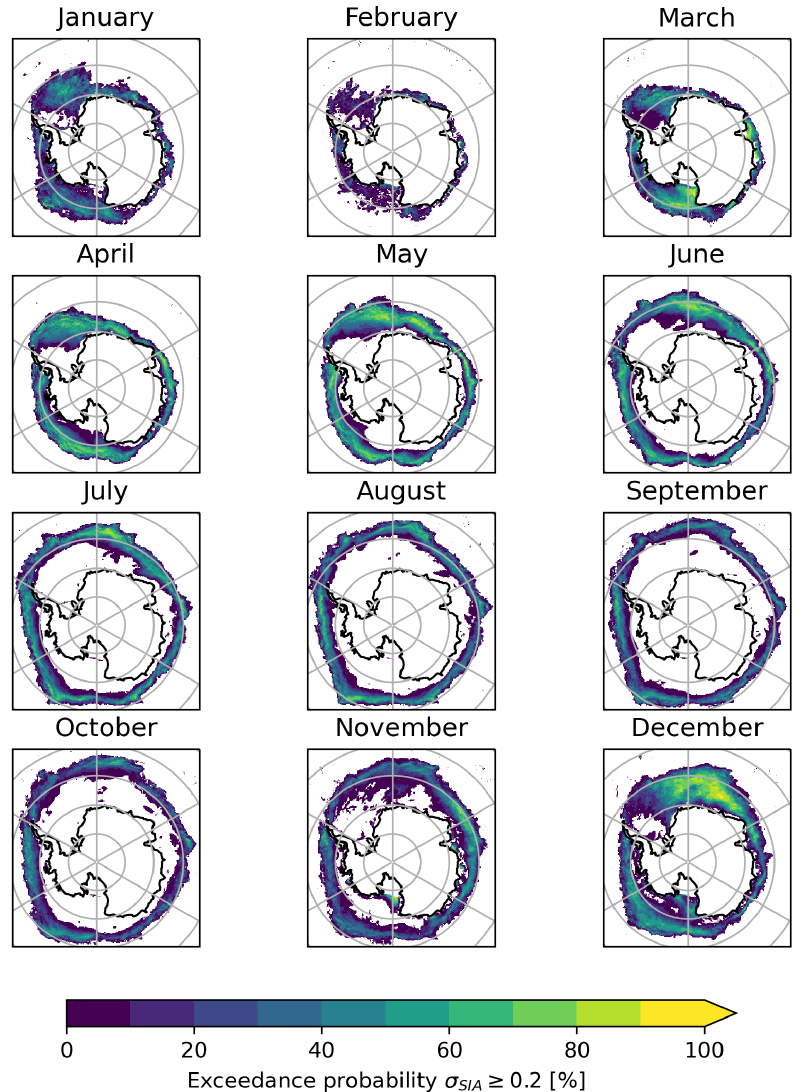
Figure 12. Monthly values of the exceedance probability for a threshold σ SIA = 0 . 2 from the NOAA/NSIDC